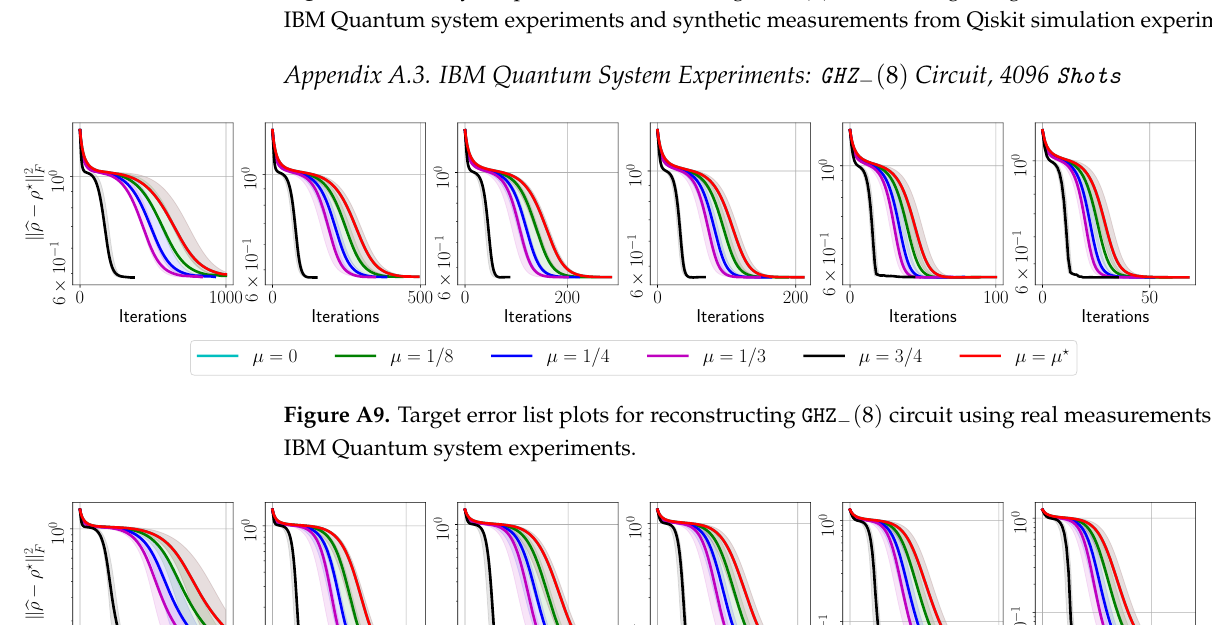
Figure A10. Target error list plots for reconstructing GHZ from IBM’s quantum